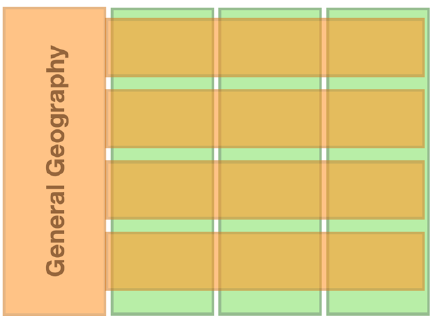
Figure 2: Regional elements in the Romanian Curriculum (orange: General Geography, green: Regional Geography) Source: the